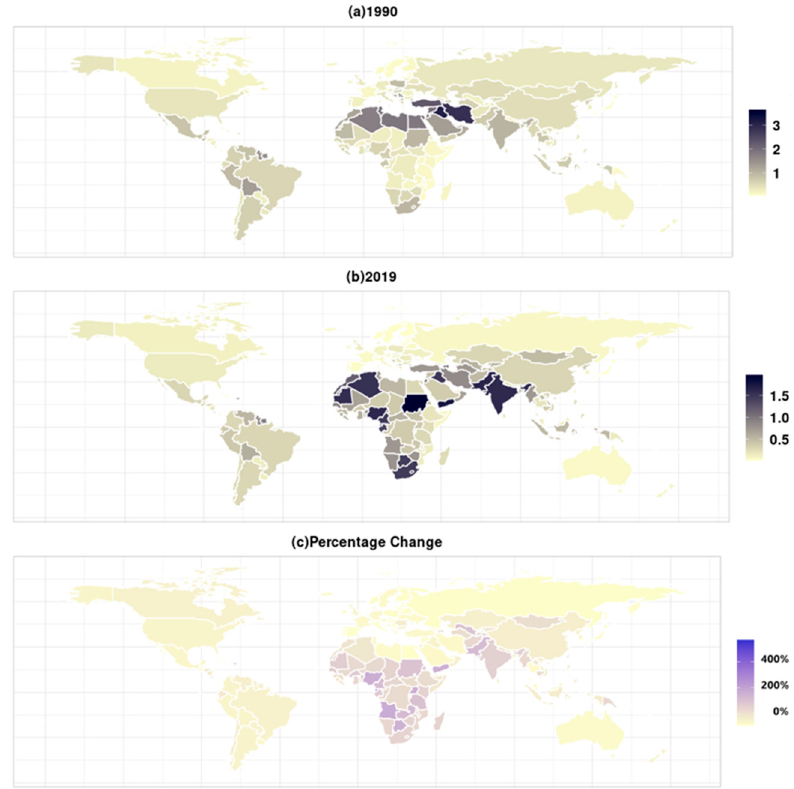
Figure 5. The global age-standardized mortality rates (per 100,000 people) and its percentage changes in PM 2.5 -related preterm birth: ( a ) 1990; ( b ) 2019; ( c ) percentage changes from 1990 to